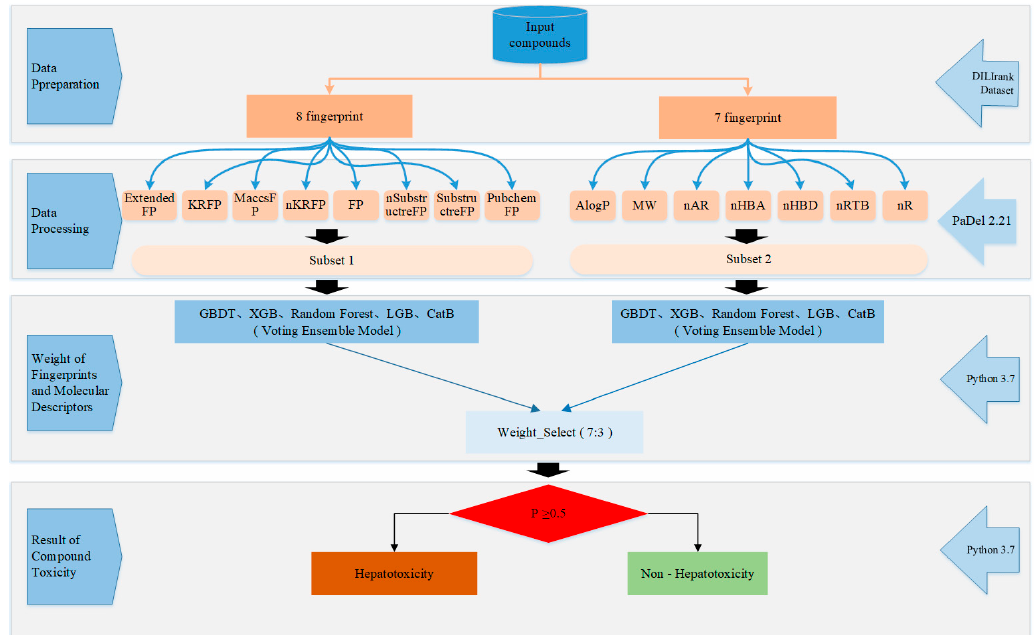
Figure 5. Flowchart of the ensemble model.